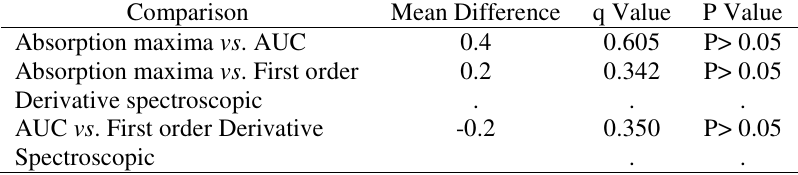
Table 3. Results of one way ANOVA (Tukey-Kramer multiple comparison test) Comparison Mean Difference Absorption maxima vs .